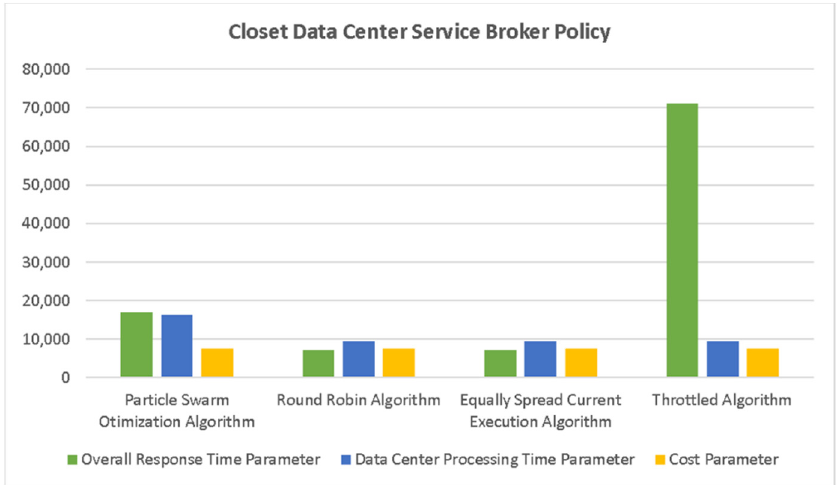
Figure 15. The comparison of PSO and RR, ESCE, and throttled algorithms by considering the parameters based on CDC SBP.